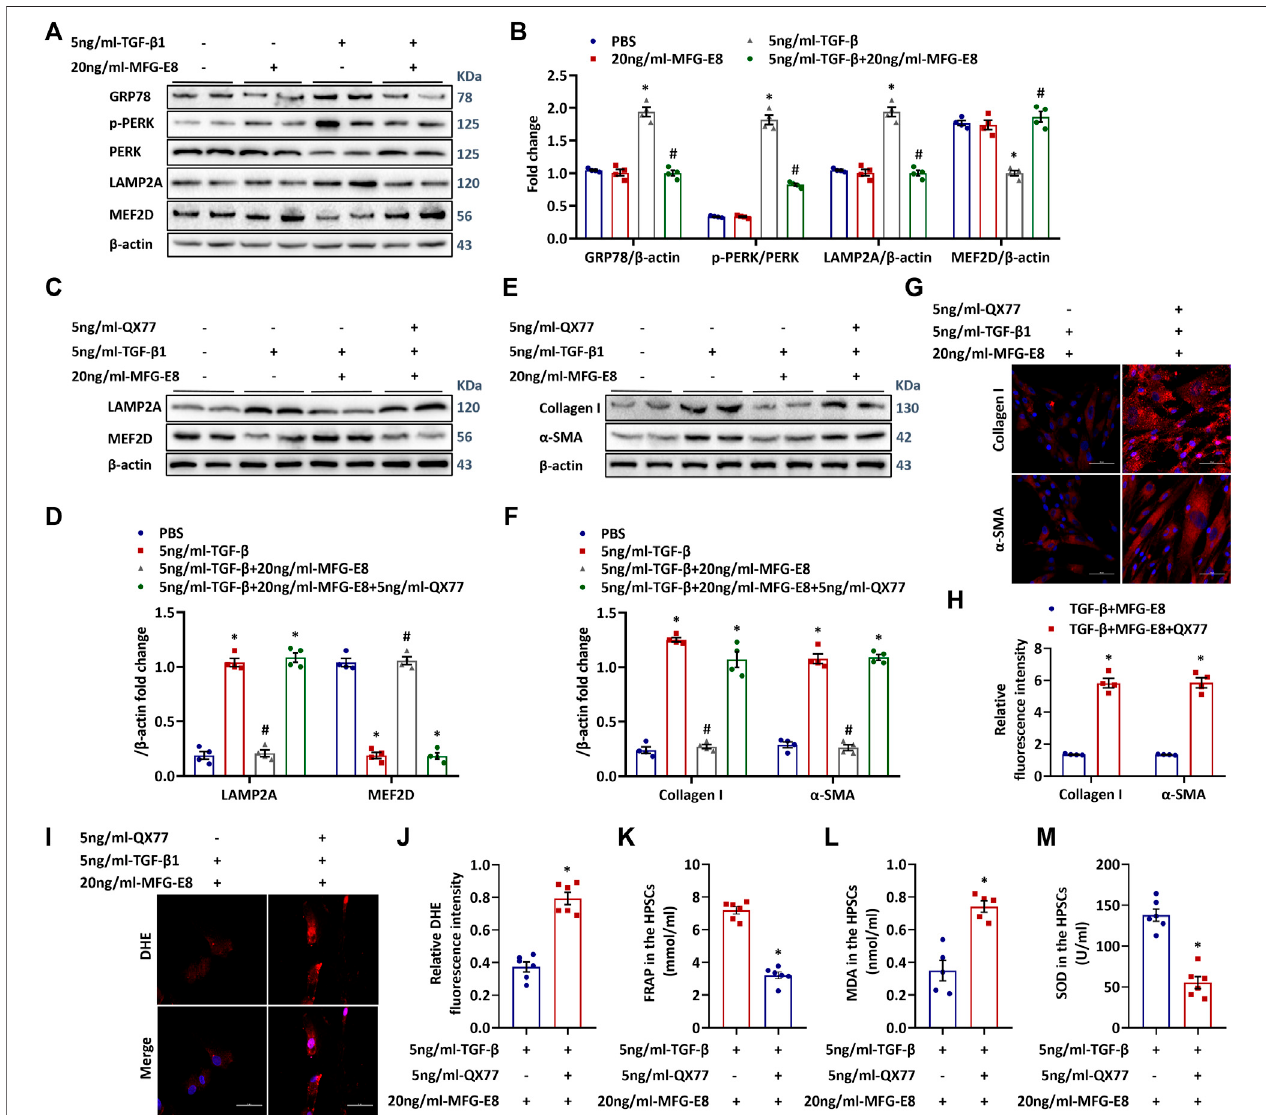
FIGURE5|ERStressInducedCMAMediatetheActivationofHPSCs. Humanpancreaticstellatecells(1 × 10 6 /well)weretreatedwith5 ng/mlTGF- β 1withor without 20 ng/ml MFG-E8 for 24 h, the same volume of PBS was added to another group of HPSCs as a control group. To determine the role of ER stress-mediated CMA activation in exogenous MFG-E8 ’ s effect in HPSCs, QX77, a LAMP2A-speci fi c activator, was added simultaneously with 20 ng/mL-MFG-E8 in TGF- β 1-treated HPSCs. (A,B) Western blot analysis of the expression of GRP78, p-PERK, PERK, LAMP2A and MEF2D in the HPSCs (one-way ANOVA with the Tukey-Kramer test); (C,D) Western blot analysis of the expression of LAMP2A and MEF2D in the HPSCs (one-way ANOVA with the Tukey-Kramer test); (E,F) Western blot analysis of the expression of α -SMA and Collagen I in the HPSCs (one-way ANOVA with the Tukey-Kramer test); (G,H) Representative images and quantitative analysis of immuno fl uorescence staining of α -SMA and collagen I in the HPSCs ( t -test); (I,J) Representative images and quantitative analysis of immuno fl uorescence staining of DHEintheHPSCs( t -test); (K) FRAPlevel intheHPSCs( t -test); (L) MDAlevelintheHPSCs( t -test); (M) SODlevelintheHPSCs( t -test). n (cid:1) 4 – 6,mean ± SEM; p p < 0.05 versus Sham group; # p < 0.05 versus Vehicle group. α -SMA, alpha-smooth muscle actin; TGF- β 1, transforming growth factor- β 1; HPSCs, human pancreatic stellate cells, MFG-E8, Milk Fat Globule-EGF Factor 8; DHE, Dihydroethidium; LAMP2A, Lysosomal associated membrane proteins 2a; MDA, malondialdehyde; SOD, superoxide dismutase; FRAP, Ferric ion reducing antioxidant power.